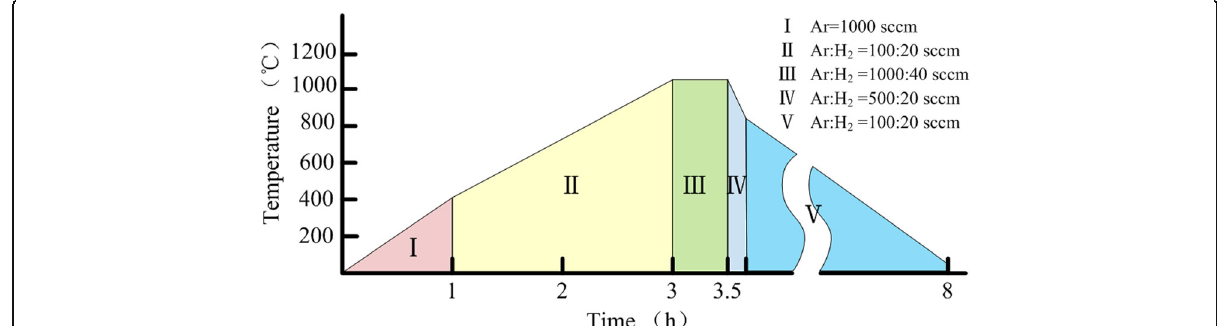
Fig. 2 Thermal processing conditions for SiNW synthesis using a horizontal furnace. In stage I, the temperature was increased from room temperature to 400 °C in 1 h with the same Ar flow which used to exclude air. In stage II, Ar flow was adjusted to 100 sccm, and 20 sccm H 2 was added. It took 2 h to reach 1080 °C. In this stage, copper patterns changed into hemispheres. Then, temperature was held for 30 min with 1000 sccm Ar and 40 sccm H 2 in stage III. After turning off the furnace, the fast cooling process only 10 min was taken as the IV stage and the flow was adjusted to 500 and 20 sccm respectively. In the last stage, slow cooling used to decrease the furnace temperature to room